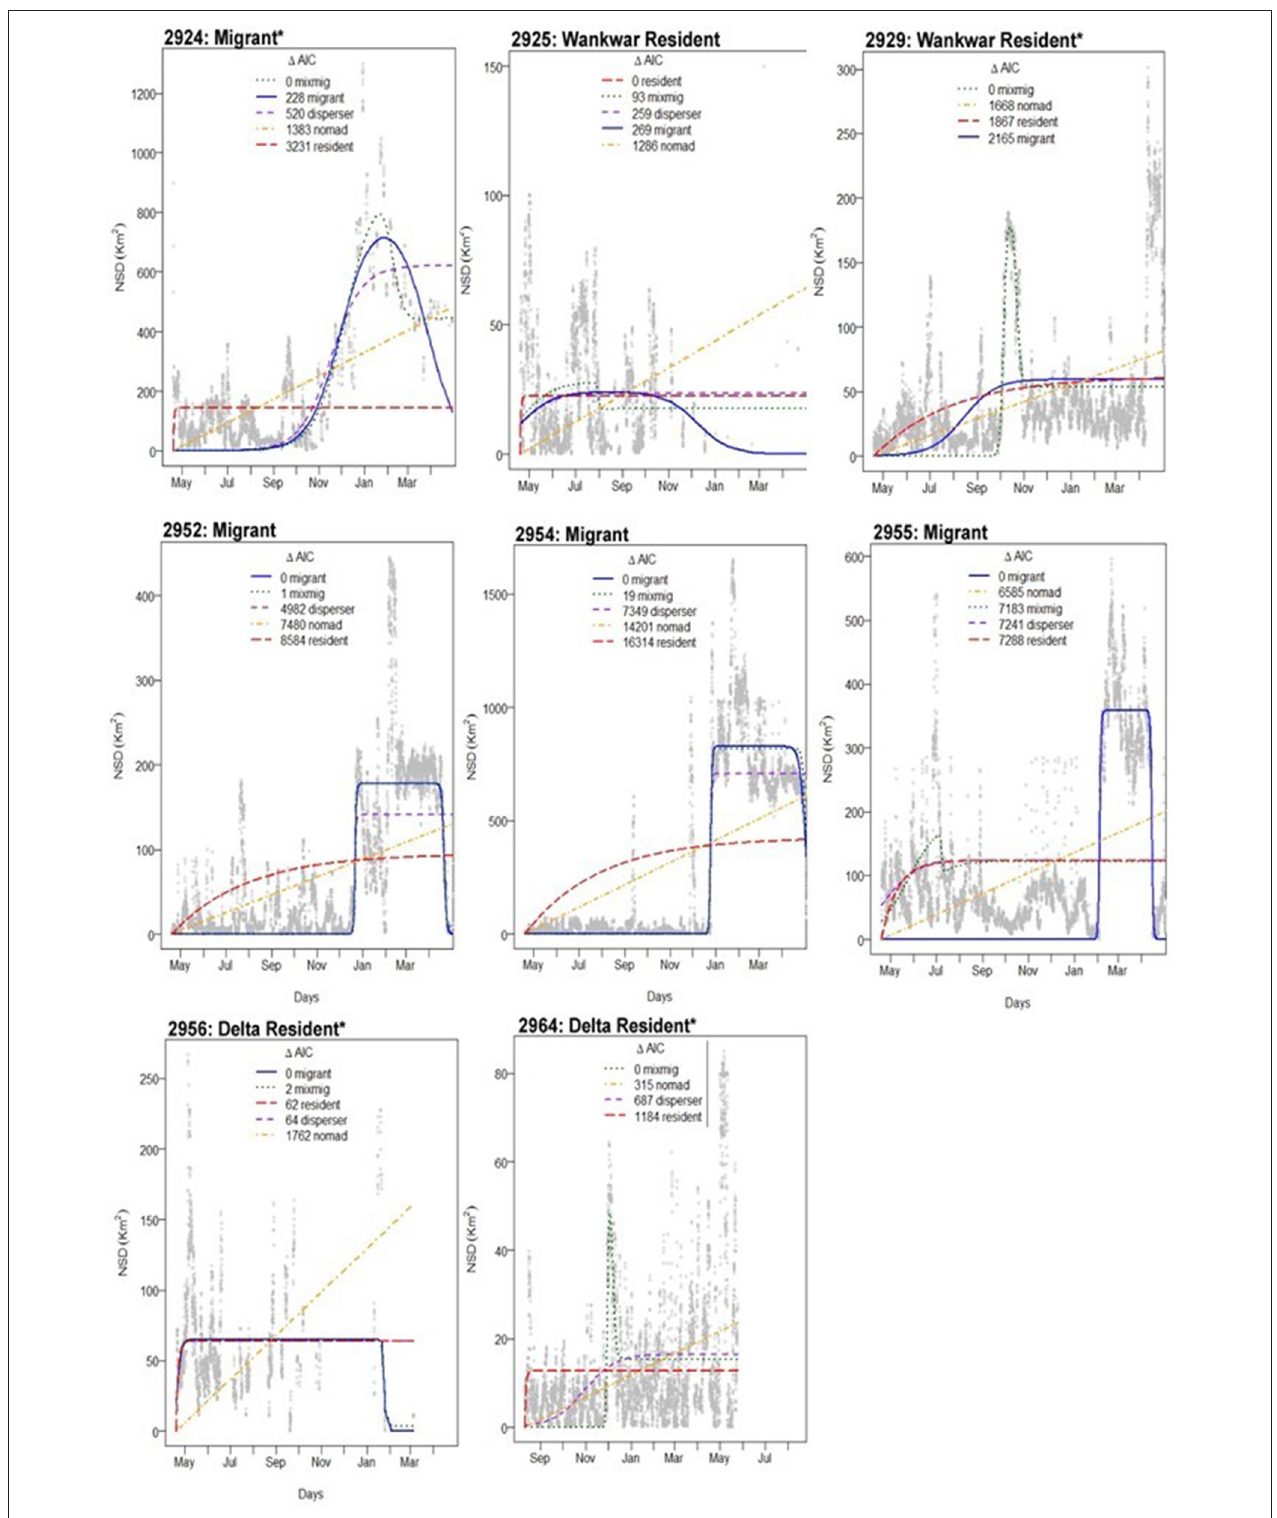
FIGURE 3 | Net squared displacement (NSD) timeseries patterns for individual giraffe over one seasonal transition from wet seasons to dry season. For individuals categorized as migrants, the shift in range coincided with the end of the wet season in late December. Note: Axis scales are different for each timeseries. Individuals in which movement classes are determined by post-hoc decisions criteria are denoted with an asterisk (*).